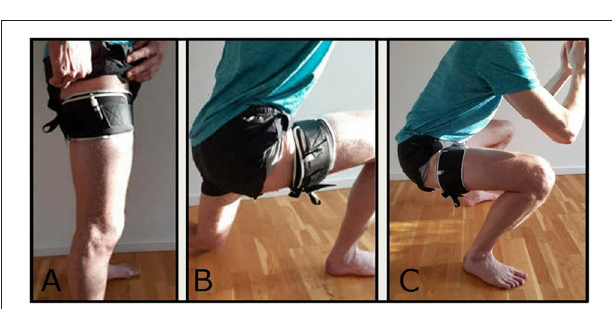
FIGURE 2 | (A) Placement of the pneumatic cuff; (B) illustration of the lunge exercise; (C) illustration of the squat exercise. TABLE 1 | Exercise